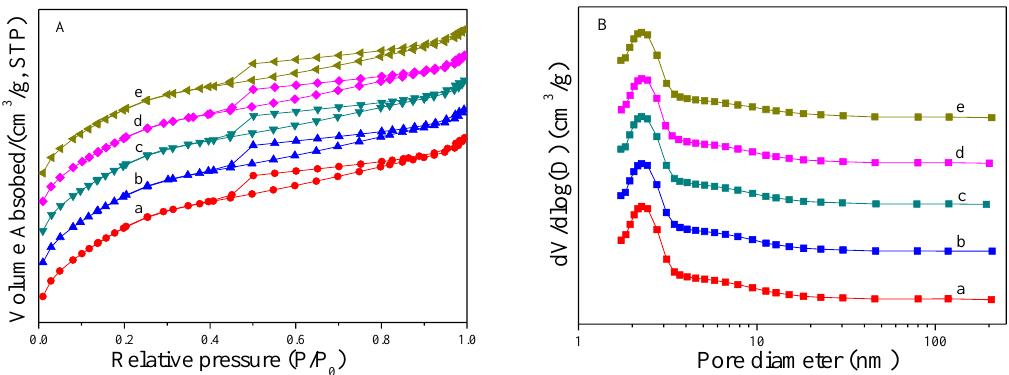
Figure 1. ( A ) N 2 adsorption – desorption isotherms and ( B ) pore size distributions of the calcined PtSn/DMSN catalysts with different ratios of Pt and Sn: (a) Pt/DMSN, (b) Pt 1 Sn 1 /DMSN, (c) Pt 1 Sn 2 /DMSN, (d) Pt 1 Sn 3 /DMSN, (e) Pt 1 Sn 4 /DMSN.